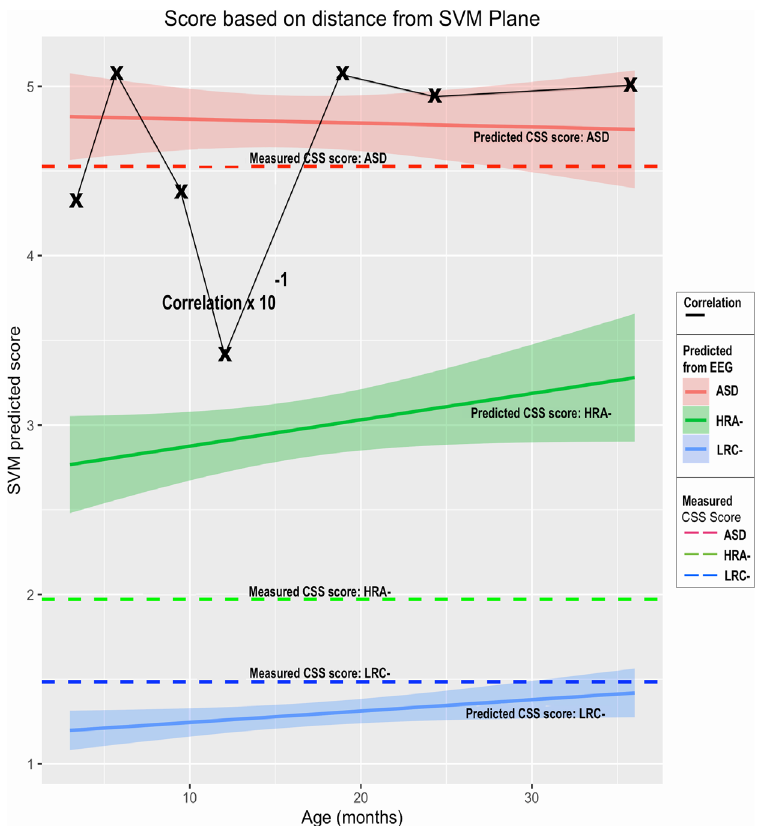
Figure 4. Measured CSS scores for each outcome group (solid lines), along with predicted scores derived from EEG features at each age are shown (dashed lines). Confidence intervals are shaded for predicted values. The age refers to the age at which EEG data was collected and used for the prediction. Correlation coefficients between predicted scores and the measured CSS values are shown by Xs if the axis values are multiplied by 10 − 1